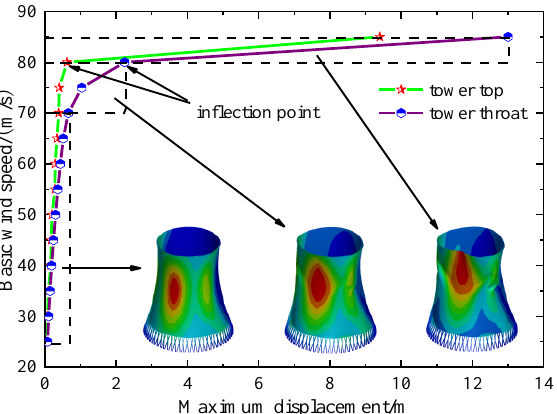
Figure 18. Schematic diagram of the maximum displacement of cooling tower with wind speed.